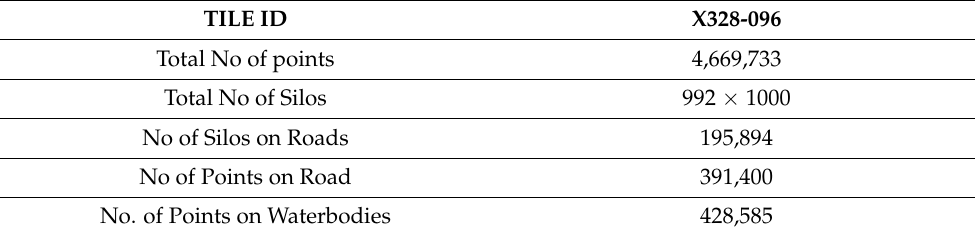
Table 2. Case 2 Results